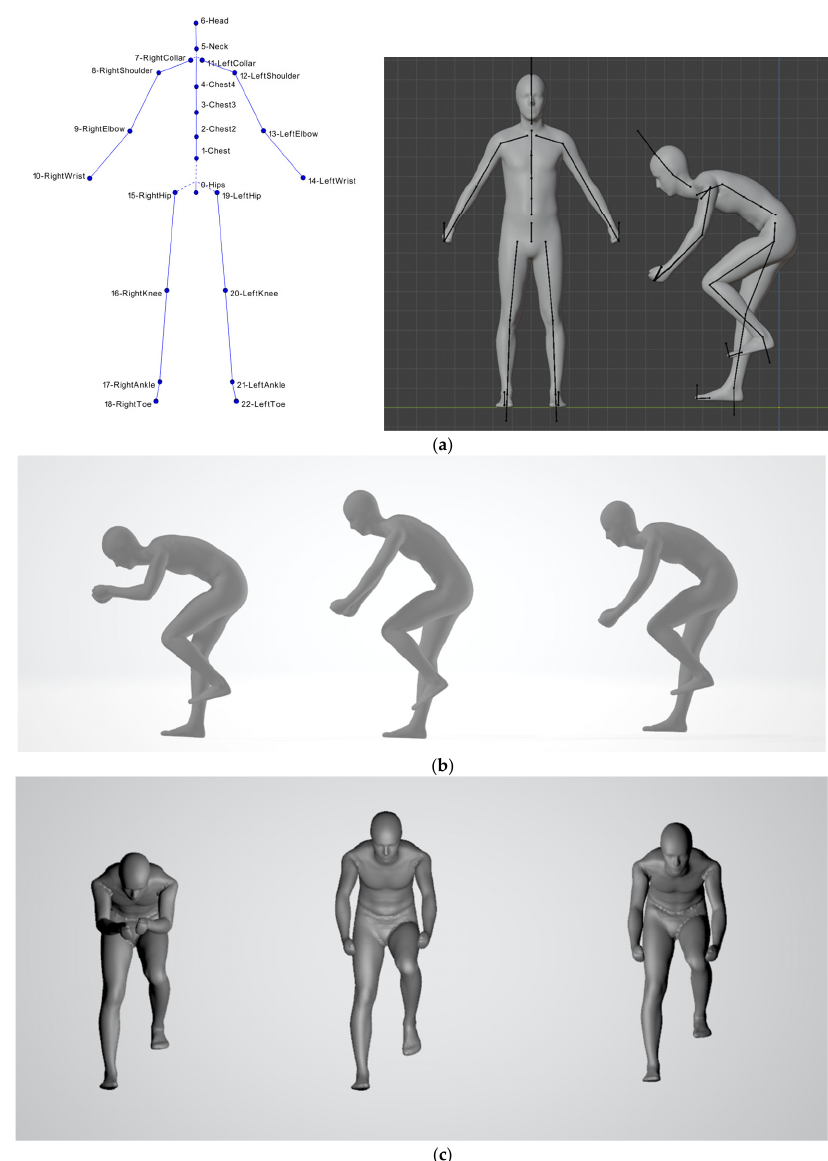
Figure 6. ( a ) (Left) The body joints used to define the rig/skeleton are listed. (Right) The rig in the standing model of one participant and the rig adapted to the Drops pose of the same participant. ( b ) 3D shapes of the participant in TT , Hoods , and Drops poses. ( c ) Front view of the 3D models of one participant in the same poses as above Using joint angles from the optical mocap, the standing models were re-posed to TT , Hoods , and Drops poses (Figure 6b,c) using animation software (Blender, Blender Foundation, Amsterdam, The Netherlands). The skeleton in the optical mocap method had fewer bones compared to the skeleton of the predicted 3D models. The angles from the optical mocap were accordingly adjusted to fit the